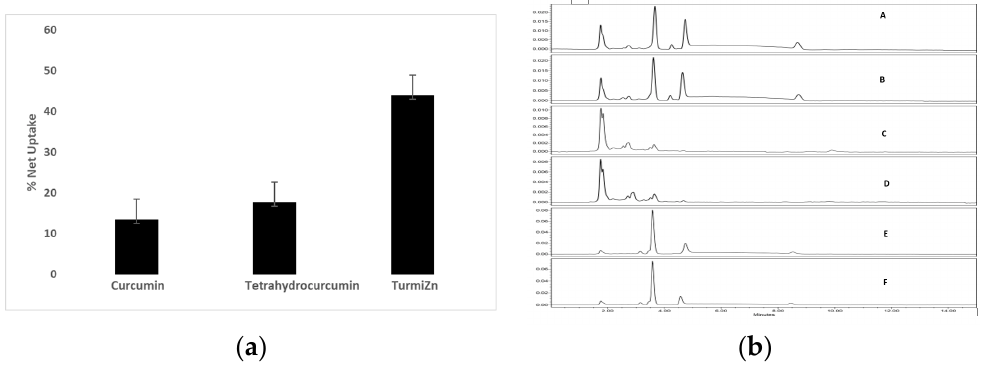
Figure 1. ( a ) Net uptake of curcumin, THC, and TurmiZn across IPEC-J2 cells. subfigure ( a ) shows the percent net uptake of curcuminoids at 425 nm, the percent net uptake of THC at 220 nm, and the percent net uptake of the TurmiZn complex measured at both 220 nm and 425 nm and averaged together, using six replicates per group. ( b ) Transwell HPLC chromatograms at 280 nm. subfigure ( b ) indicates that THC, curcuminoids, and the TurmiZn complex have the same basic respective HPLC profiles between the upper and bottom wells. A: TurmiZn top well; B: TurmiZn bottom well; C: curcumin top well; D: curcumin bottom well; E: THC top well; F: THC bottom well. Values are mean ± standard error of mean.